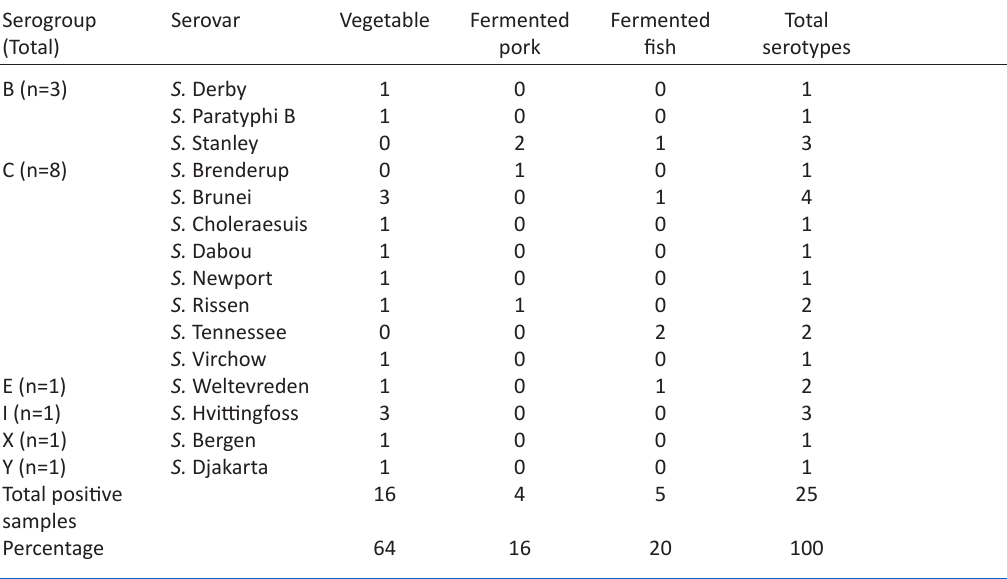
Table 1. Distribution of Salmonella serovars in vegetables and fermented pork and fish Serogroup Serovar Vegetable Fermented Fermented Total pork fish